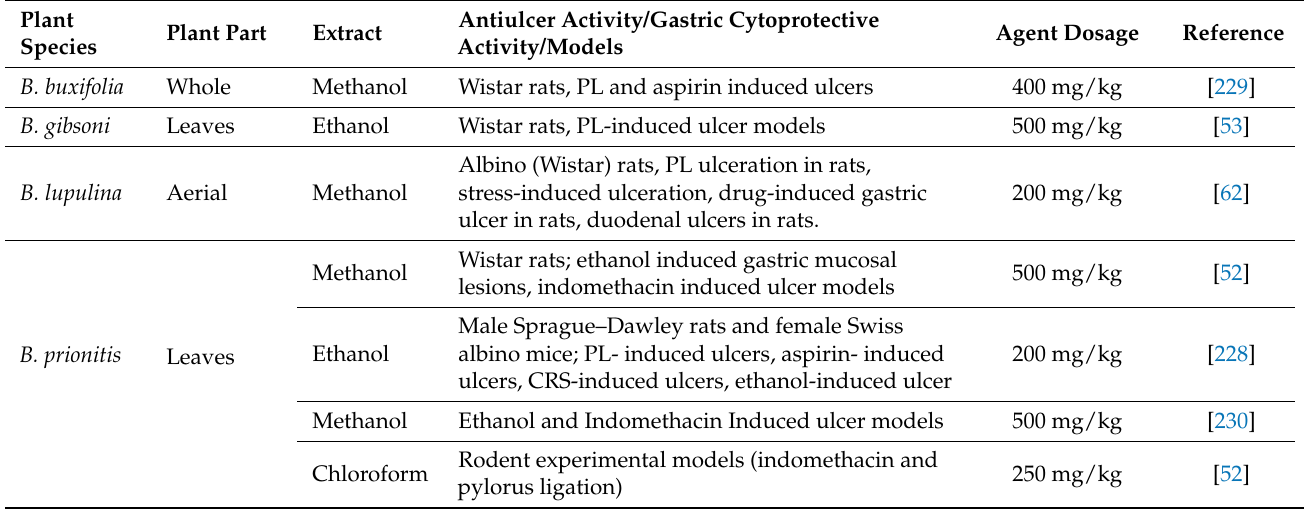
Table 8. Antiulcer activities of extracts and fractions from species within Barleria